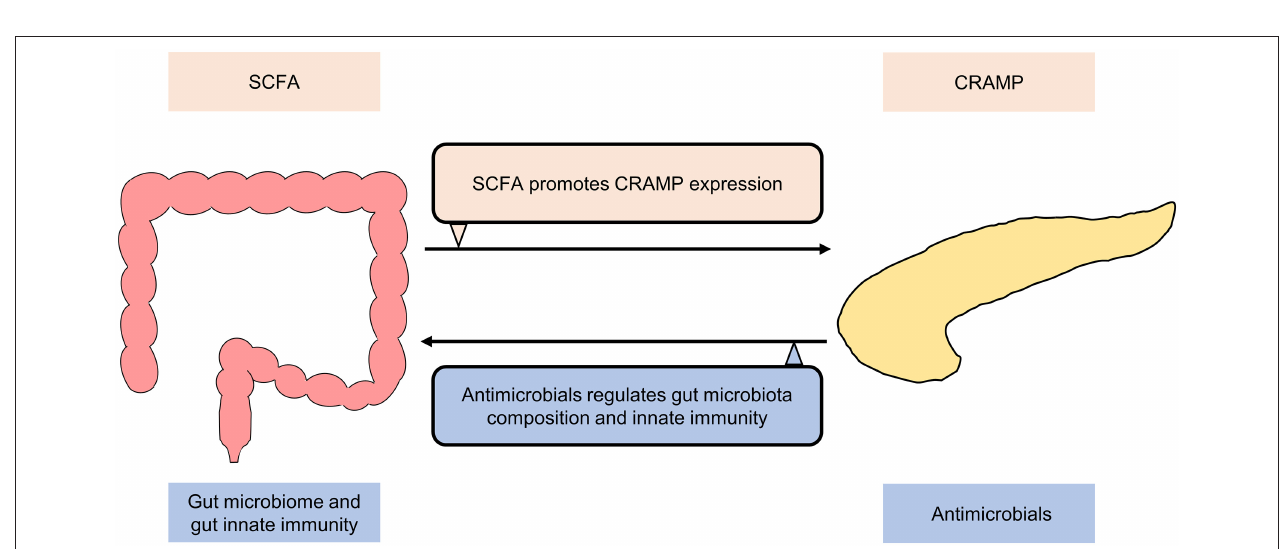
FIGURE 2 | Bidirectional communication between gut and pancreas under normal conditions. Cathelicidin-related antimicrobial peptide (CRAMP) production by insulin-secreting beta-cells is controlled by short-chain fatty acids (SCFA) produced by the gut microbiota. ORAI calcium release activated calcium modulator 1 (Orai1) produced by pancreatic acinar cells mediates the secretion of antimicrobials, which shapes the gut microbiome and regulates gut innate immunity.